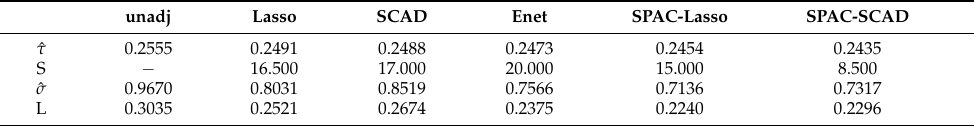
Table 4. The performance of different methods for the treatment effect estimation of trastuzumab. unadj Lasso SCAD Enet SPAC-Lasso SPAC-SCAD ˆ τ 0.2555